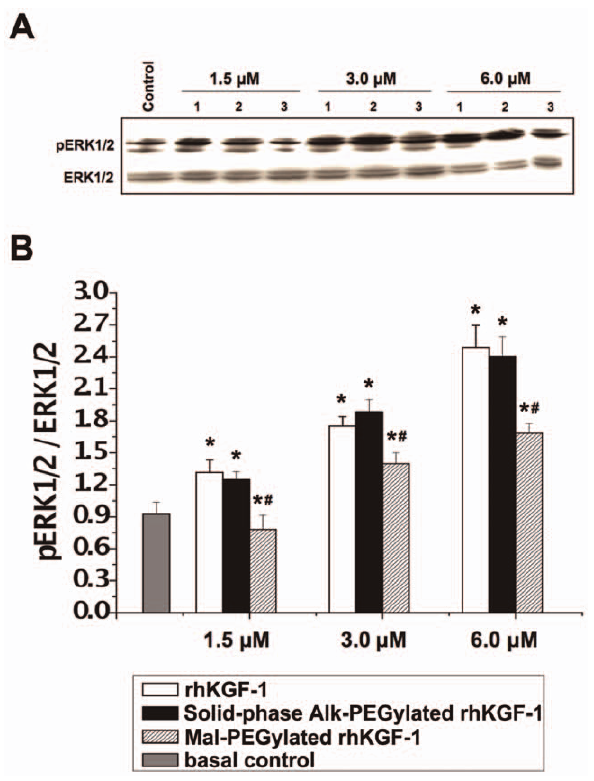
Figure 4. The effect of rhKGF-1 PEGylation on MAP kinase activation. Panel A. NIH 3T3 fibroblasts were stimulated with rhKGF-1 or PEGylated rhKGF-1 at three does 1.5 m M, 3 m M, and 6 m M, and phosphorylation courses of ERK1/2 (p-ERK) were measured by immunoblotting alongside total ERK as loading controls. The blots shown are representative of three independent experiments; Panel B. Semi-quantitative analysis of the protein bands in Panel A. *, p , 0.05 vs Normal control; # , p , 0.05 vs the corresponding non-PEGylated rhKGF-1 group.